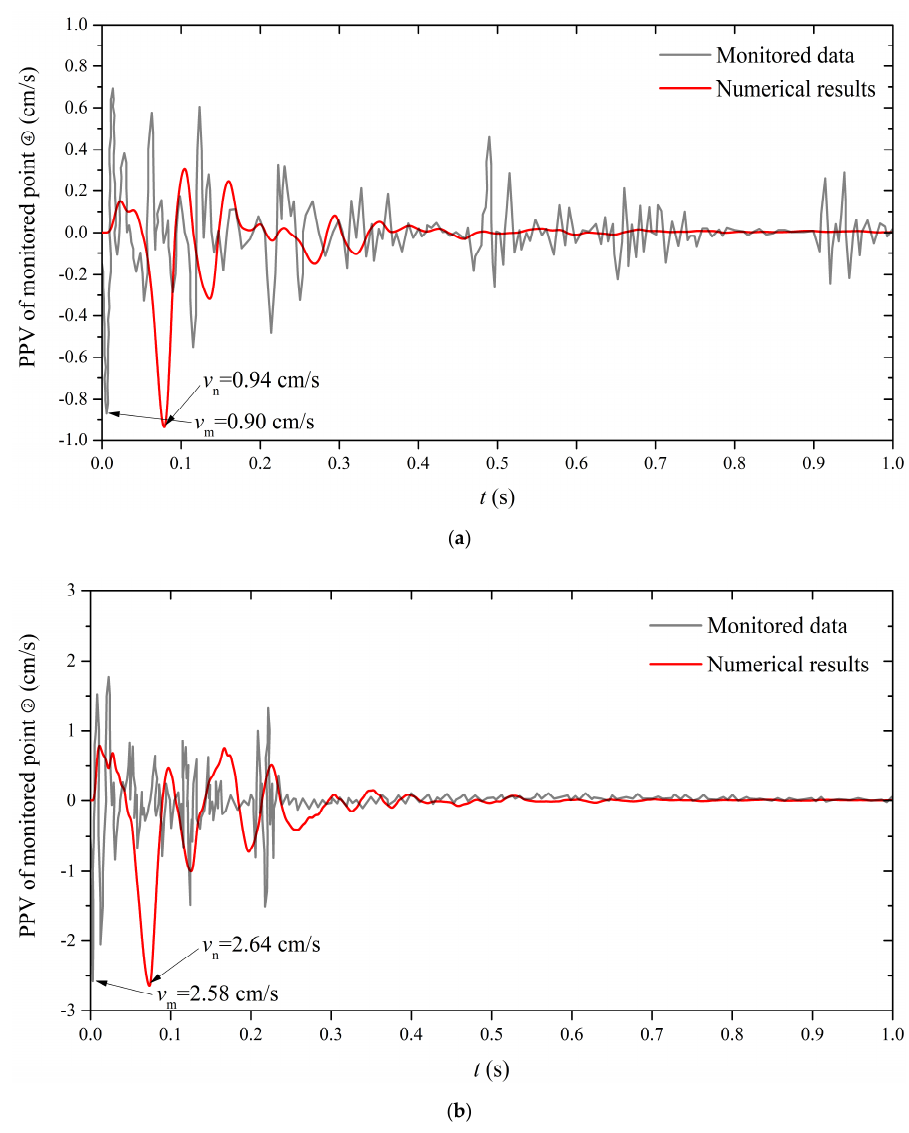
Figure 9. Comparison of vibration velocity waveforms: ( a ) PPV of monitored point ④ induced by the 2nd pilot tunnel; ( b ) PPV of monitored point ② induced by the 4th pilot tunnel.